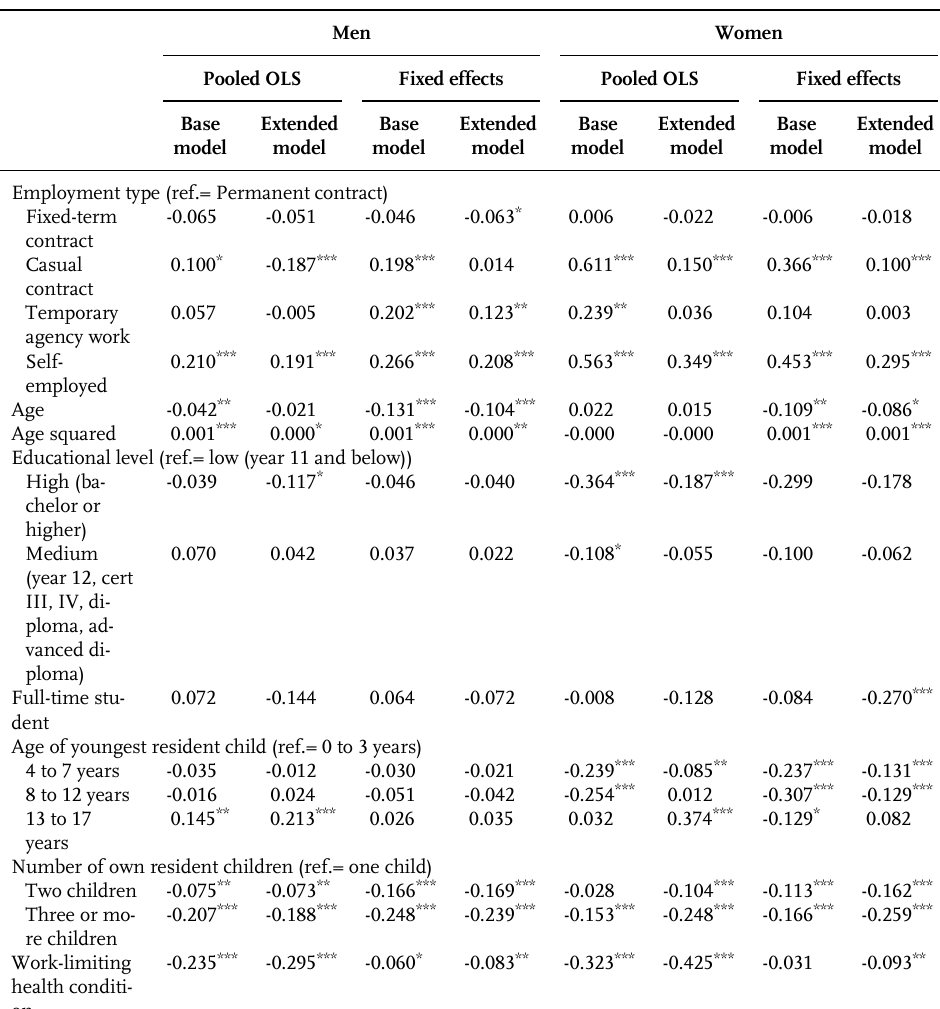
Table A.4 : Employment types and WFC (reflected scale) of parents with children aged 17 and younger (full models) Men Pooled